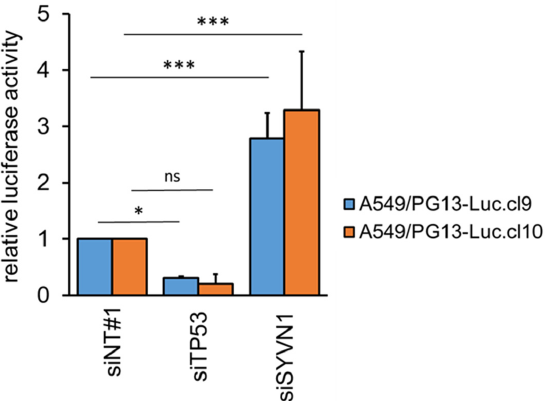
Figure 1. SYVN1 silencing induces p53 activity in A549 cells. P53 activation upon gene silencing was determined in two independent A549-derivative cell lines carrying p53 reporter construct PG13-Luc. Cells were transfected with 50 nM small interfering RNA (siRNA) against TP53 or SYVN1 or irrelevant control siRNA. Seventy-two hours later, luciferase expression was measured. Blue and orange bars indicate results obtained on the two different A549/PG13-Luc reporter cell lines. Results shown are the mean fold induction in luciferase activity over negative control siRNA (NT#1) + SD of three or four independent experiments done in triplicate on A549/PG13-Luc.cl9 and A549/PG13- Luc.cl10 cells, respectively. Differences were tested using one-way ANOVA with Dunn’s multiple comparisons test. ns, not significant; *, p < 0.05; ***, p < 0.001. Synoviolin was previously described to sequester p53 in the cytoplasm and to pro- mote its degradation [15]. Figure 2 shows that SYVN1 silencing in A549 cells resulted in functional activation of p53 according to the mode of action described for synoviolin. RT- qPCR analysis showed that transfection of SYVN1 siRNA very efficiently silenced SYVN1 mRNA (Figure 2a). This caused an accumulation of p53 protein and enhanced expression of p21, a paradigm p53 transcriptional target gene (Figure 2b). Silencing SYVN1 substan- tially prolonged the p53 half-life from approximately 30 minutes to more than 2 hours (Figure 2c). Hence, in A549 cells, silencing SYVN1 increases p53 transcriptional activity by inhibiting synoviolin-mediated p53 degradation.